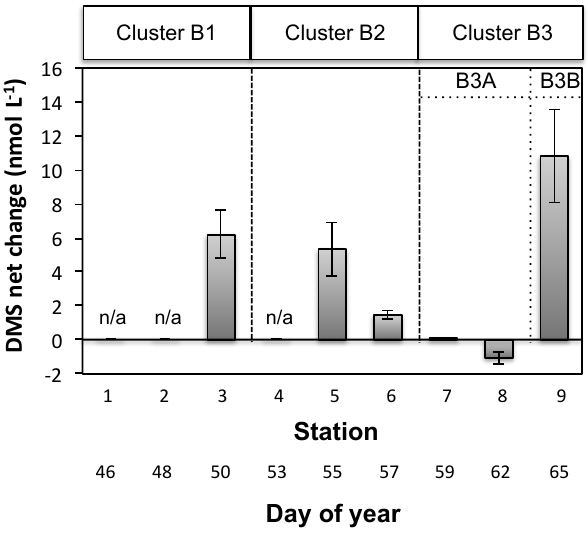
Figure 6. Net changes in DMS concentrations calculated as the dif- ference between T0 and T6 values during 6h incubation experi- ments conducted in quartz bottles (at in situ light and temperature conditions) on the deck of the ship during the SOAP voyage in February and March 2012. Stacks and error bars indicate mean and standard deviation of triplicate samples. NA indicates data that are not